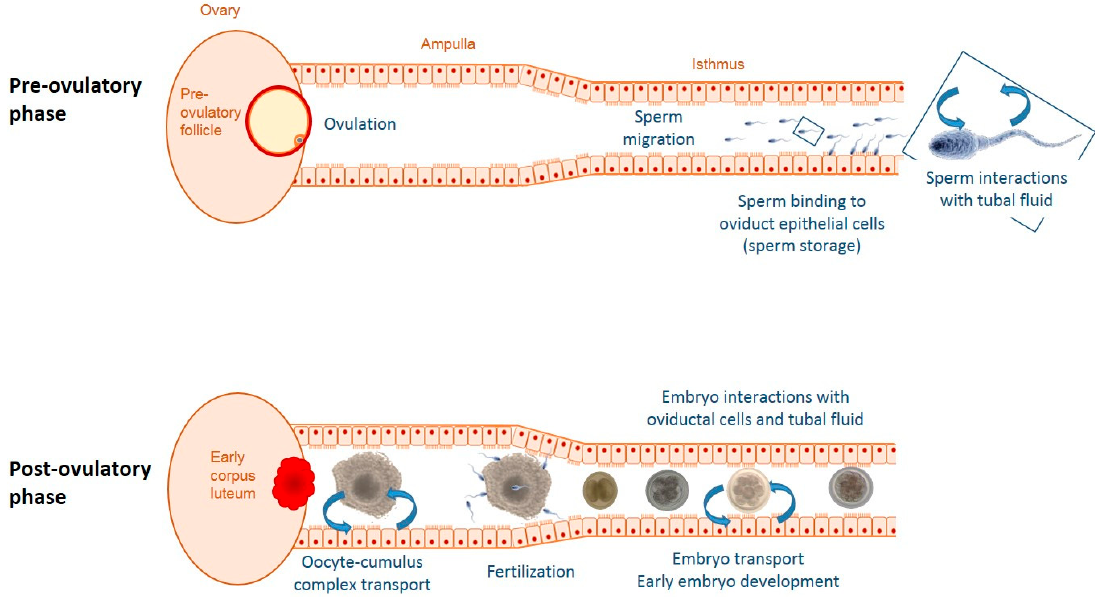
Figure 1. Schematic representation of some factors and processes responsible for changes in the oviductal microenvironment before and during embryonic development. Prior to ovulation sperm interact with the epithelial lining of the oviduct. After ovulation, the ovulated oocyte with surrounding cumulus cells as well as the developing embryo influence oviductal functions both mechanically and via para-/juxtacrine signaling. Throughout the cycle, ovarian sex steroids produced by the follicle(s) and corpora lutea modulate oviductal secretions.